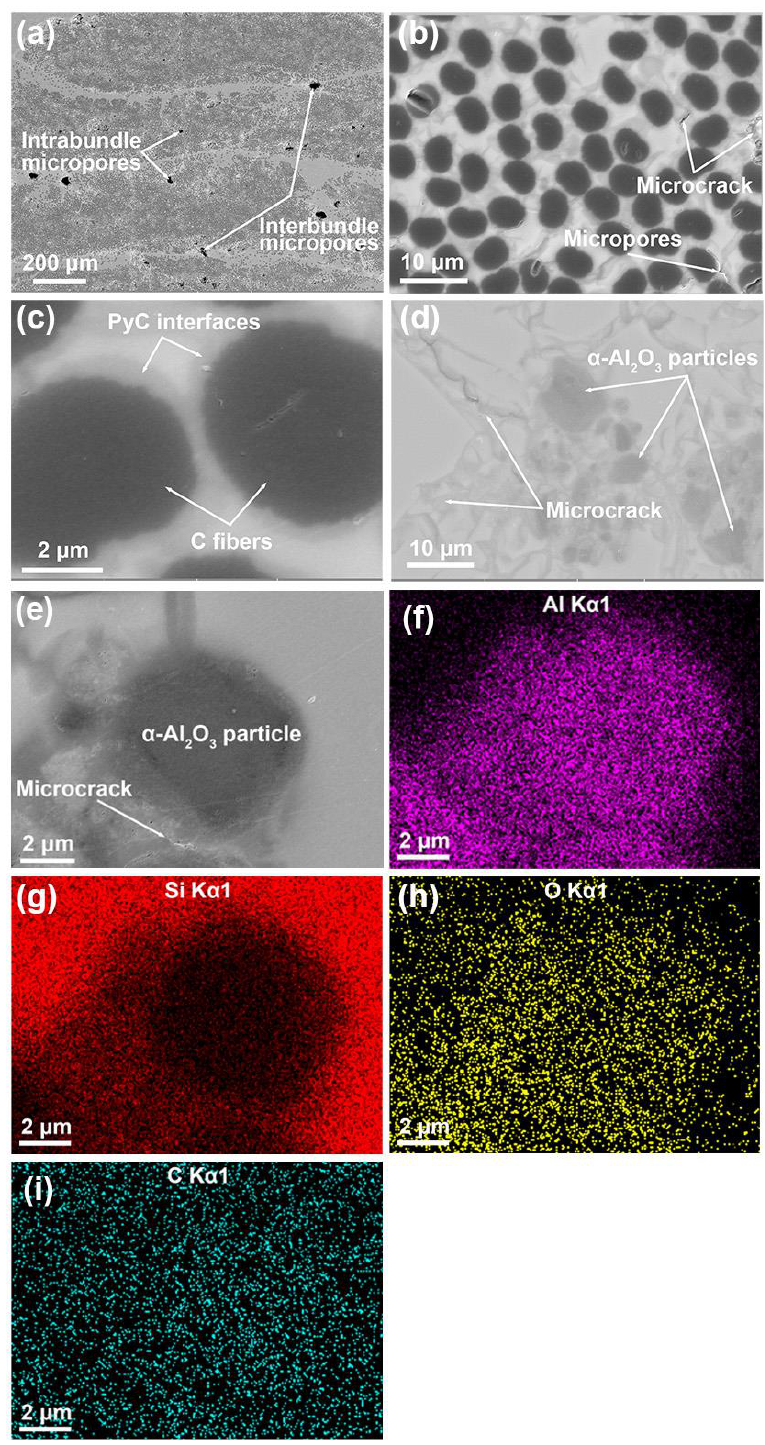
Figure 5. ( a – e ) Cross-sectional backscattered SEM images of the C f /SiC-Al 2 O 3 composite and ( f – i ) EDS maps of the ( e ).